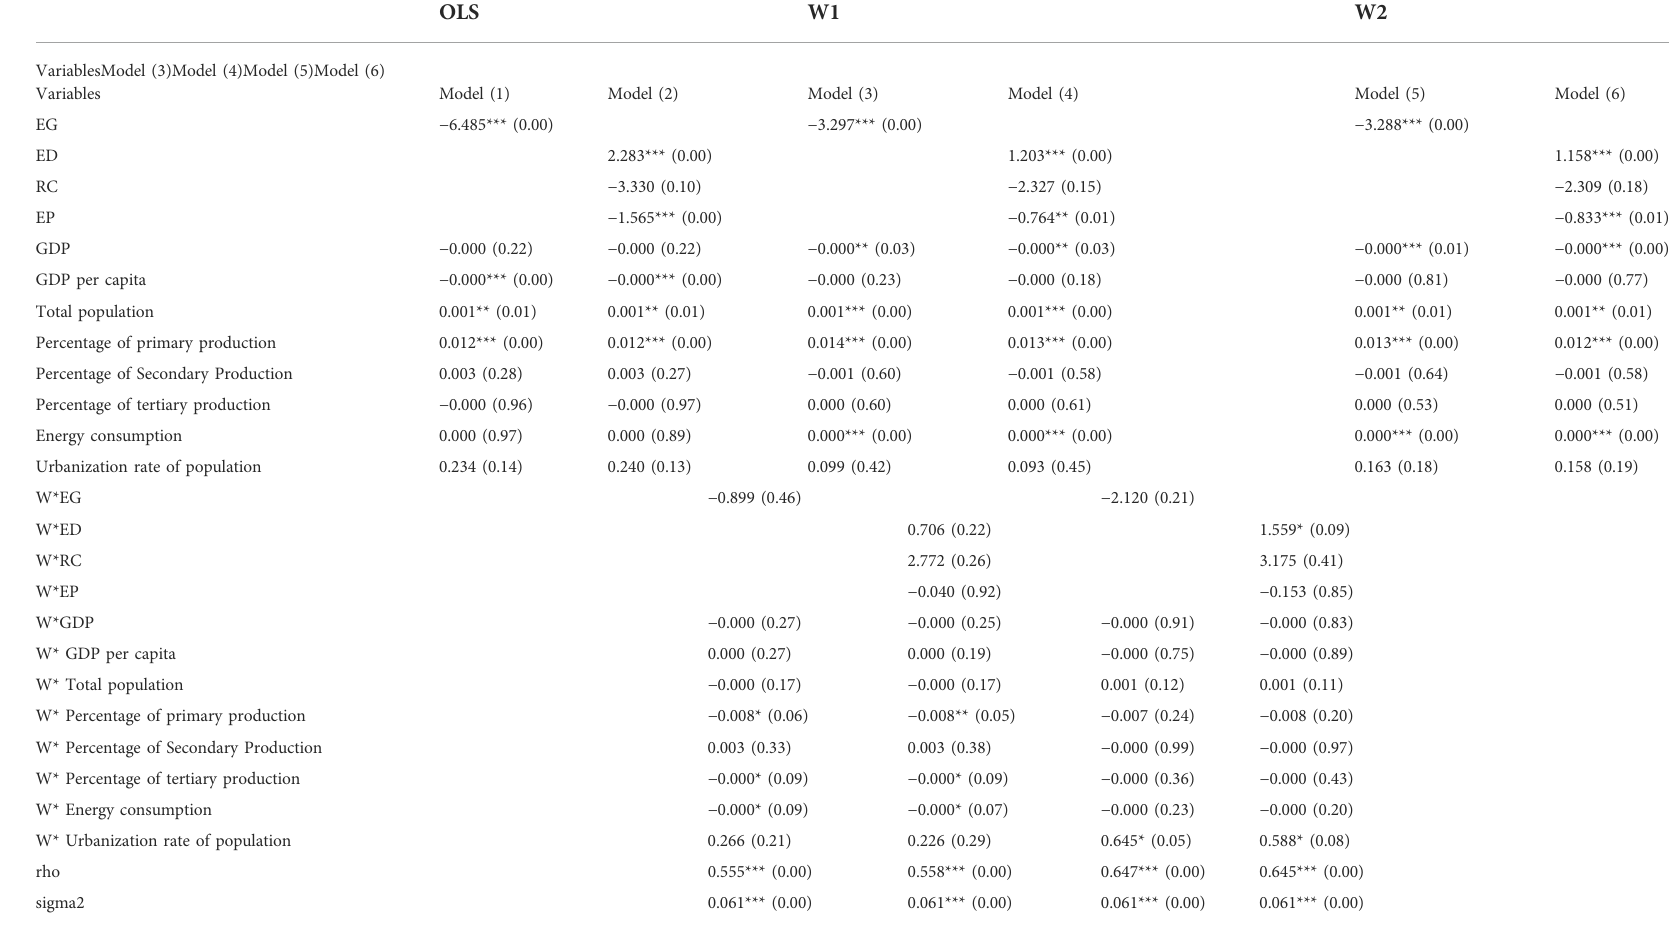
TABLE 9 Regression results of OLS and spatial Durbin